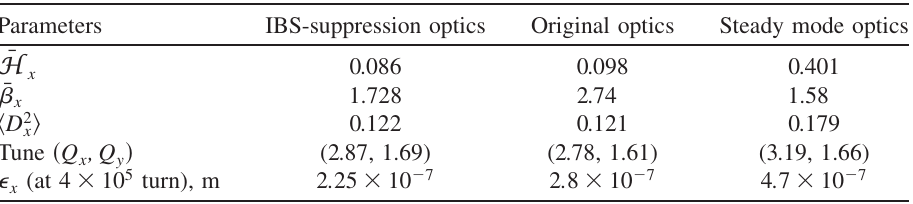
TABLE I. Average values of Twiss functions and IBS growth rate for different optics.